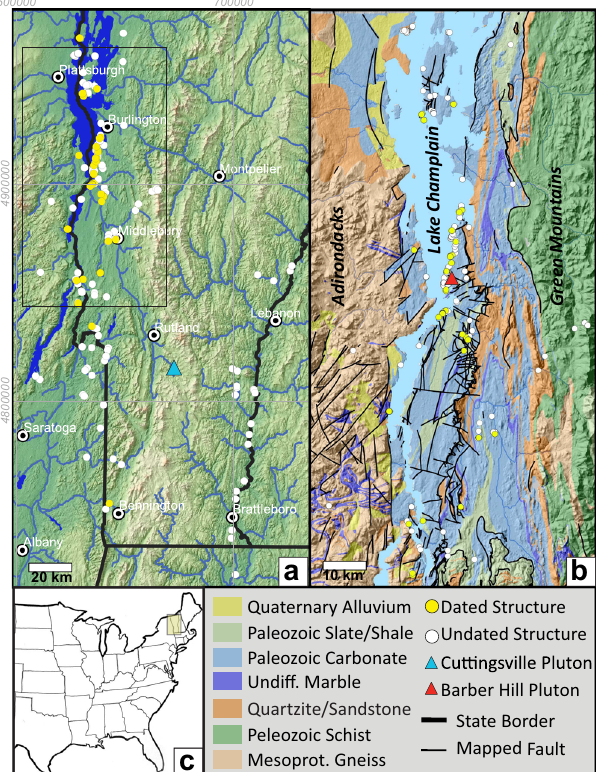
Fig. 1 Maps of the study area. a Physiographic map of the study area showing calcite samples. b Geologic map of the study area. The Champlain Valley represents the eastern edge of the North American Craton such that the western portion of the study area is composed of Proterozoic basement rocks and the eastern portion is composed of younger Paleozoic metamorphic rocks emplaced during the Taconic orogeny. The valley itself is composed of low grade Paleozoic meta-sedimentary rocks from which most samples were collected. Geologic maps from Ratcliffe et al., 2011 and Isachsen and Fisher, 1970. c Larger scale location